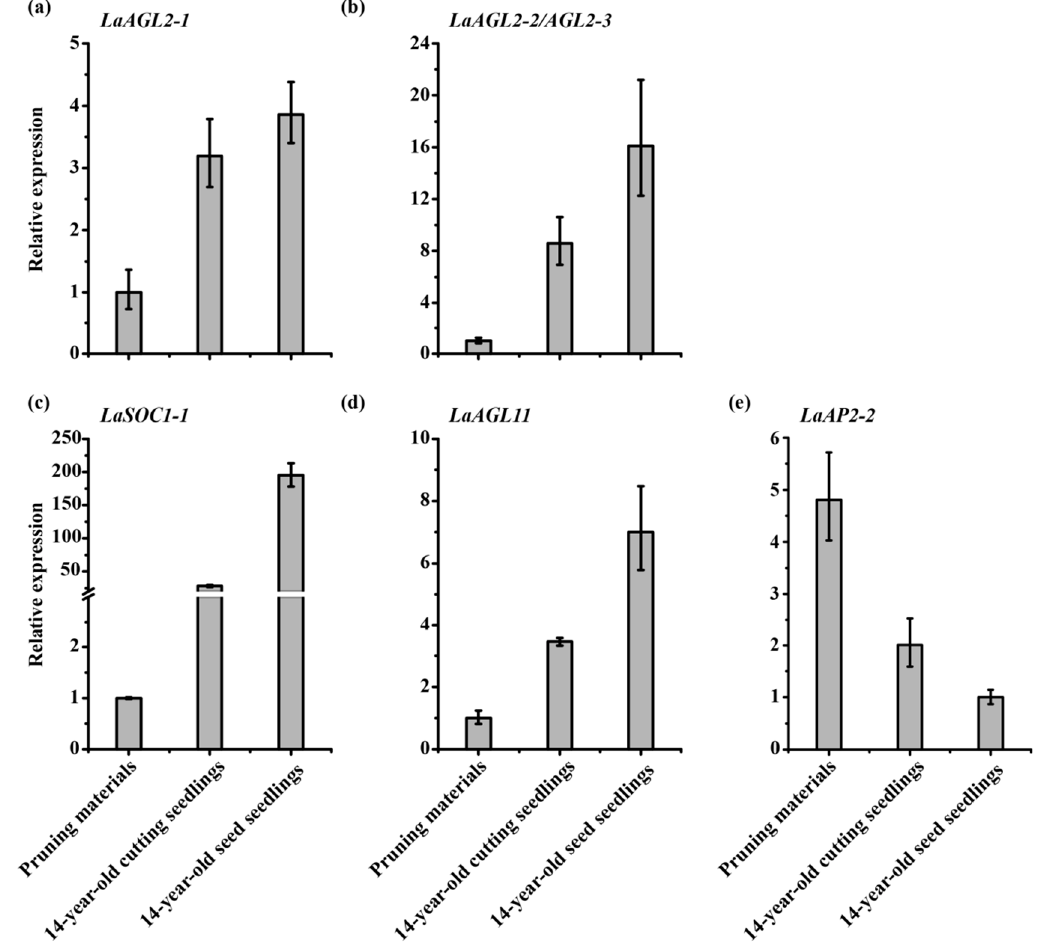
Figure 4. Expression patterns of LaAGL2 - 1 ( a ), LaAGL2 - 2 ( b ), LaAGL2 - 3 ( b ), LaSOC1 - 1 ( c ), LaAGL11 ( d ), and LaAP2 - 2 ( e ) in 14-year-old Larix kaempferi pruning materials ( n = 3, sampled in 2018), cutting seedlings ( n = 3, sampled in 2018), and seed seedlings ( n = 3, sampled in 2018) assayed by qRT-PCR with LaFBP1 as the internal control.